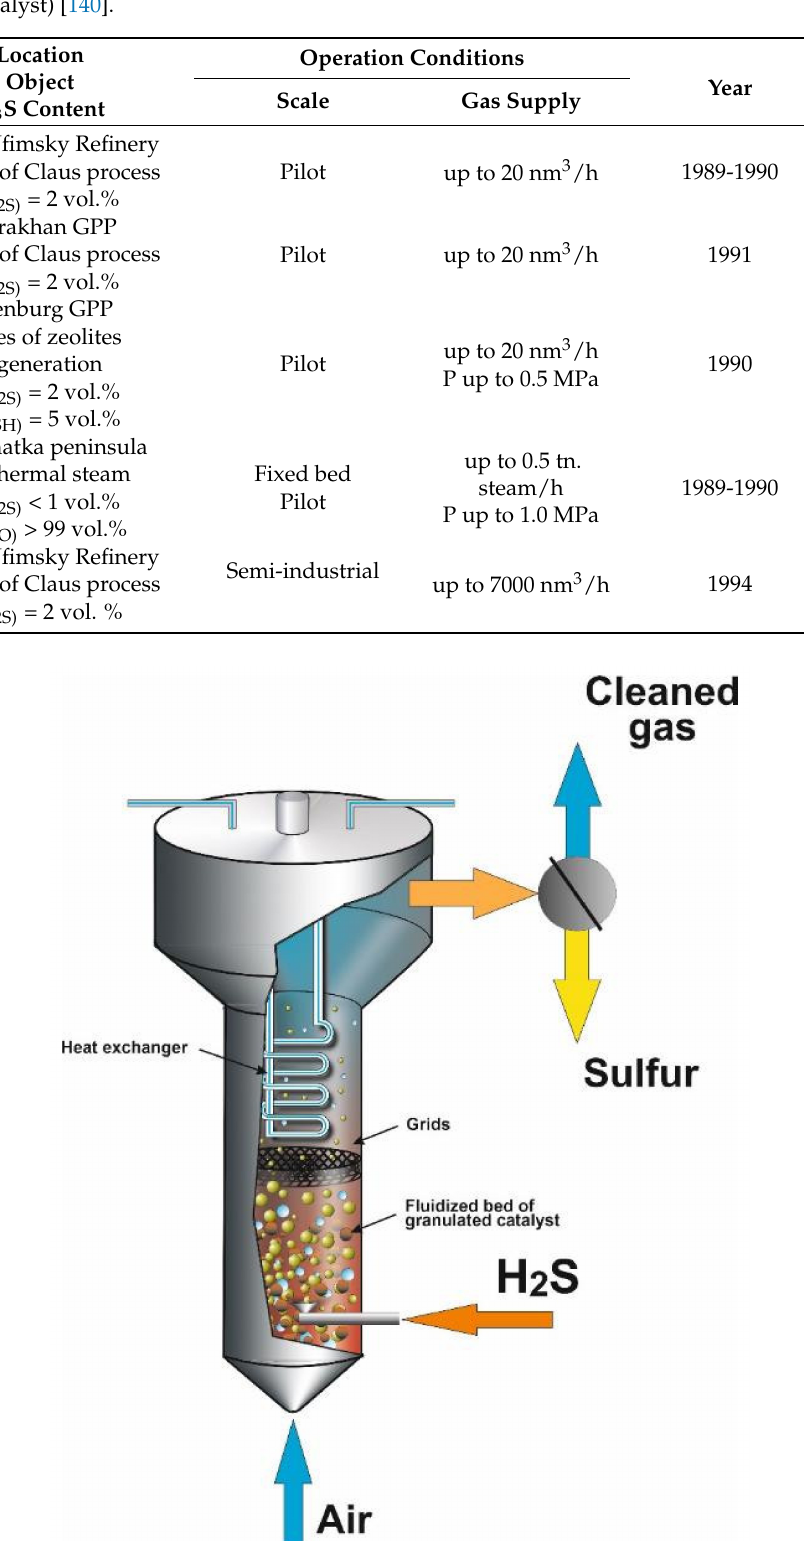
Table 3. Pilot and experimental industrial tests of the technology of direct catalytic oxidation of hydrogen sulfide (Modifica- tion 2-Honeycomb Catalyst) [140].